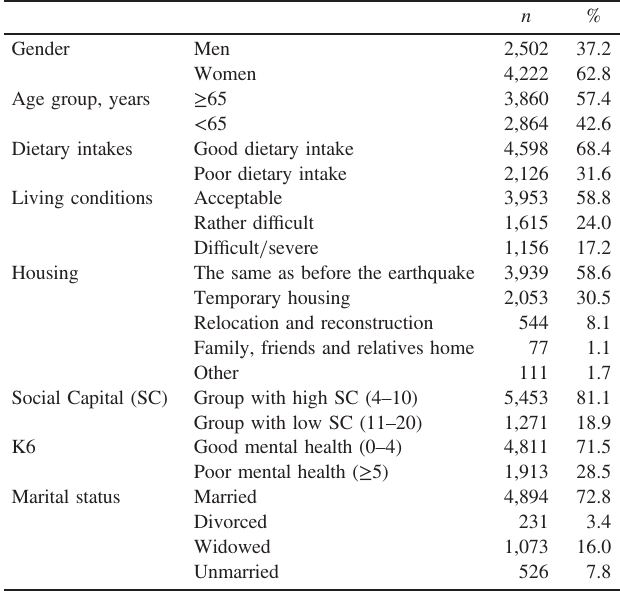
Table 2. Characteristics of participants ( n = 6,724)